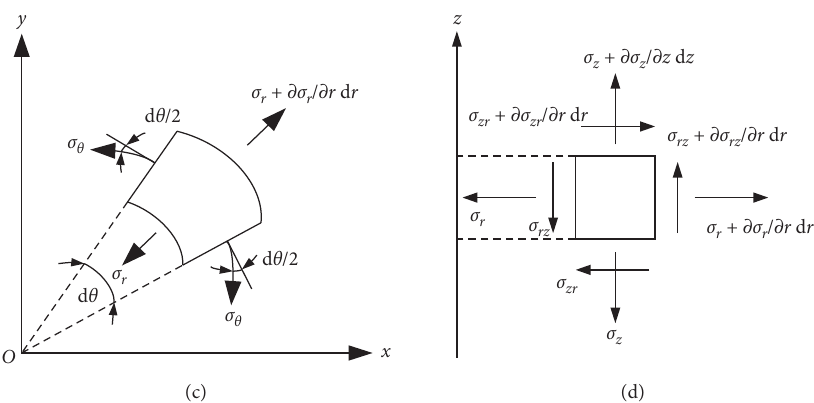
Figure 4: Mechanical model of the metal prestressed tube: (a) overall stress of metal prestressed tube, (b) infinitesimal element, (c) x − y plane force, and (d) r − z plane